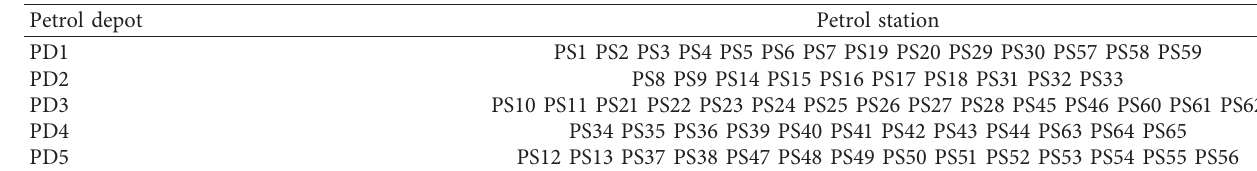
Table 3: Initial petrol stations’